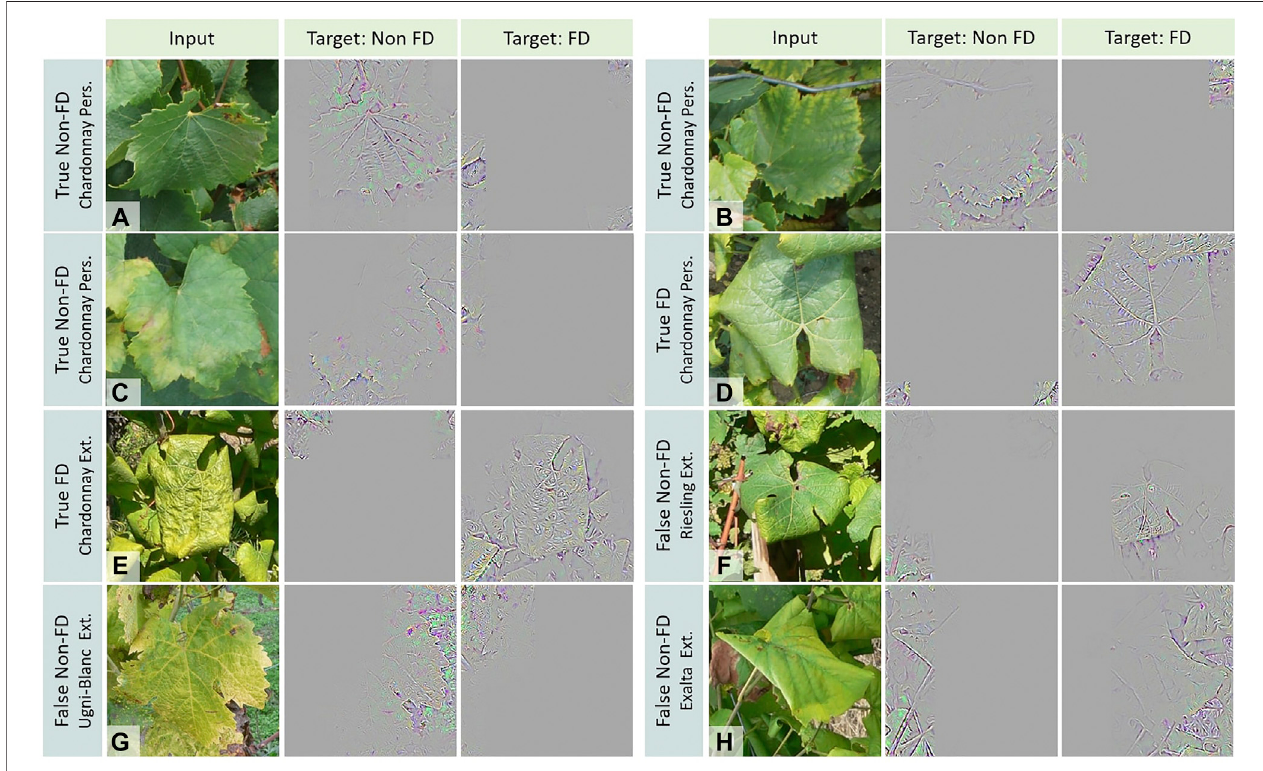
FIGURE 9 | Illustration of representative features from Guided Grad-CAM that are used by the model to predict the Flavescence dorée (FD) and Non-FD classes. ( A – C) : Non-FD images, (D – H) : FD images. The predicted label and the source dataset are given next to each